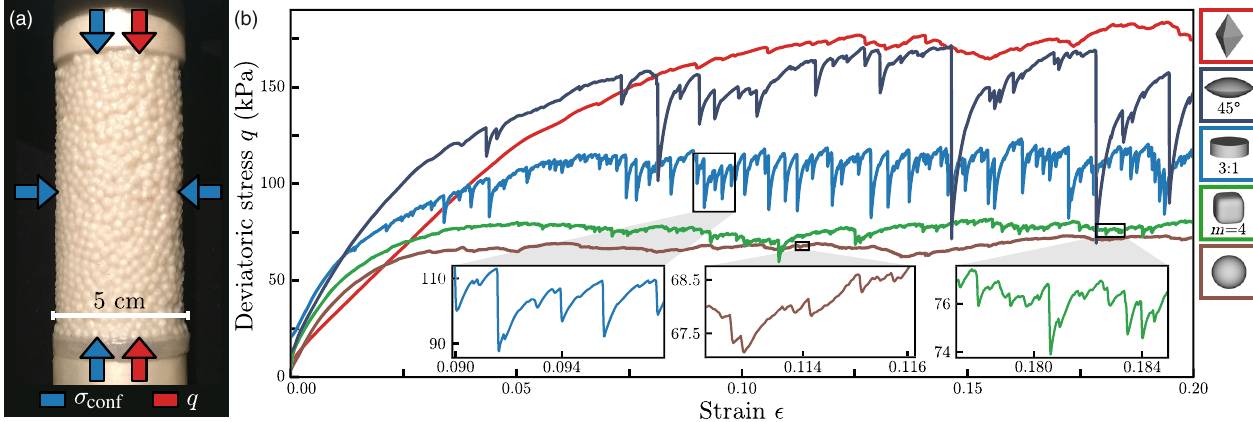
FIG. 1. Triaxial compression into the plastic regime. (a) A 10-cm-tall, 5-cm-diameter packing of icosahedra in a rubber membrane and ¼ 20 kPa before uniaxial stress q is applied. (b) Raw stress-strain data for a single run each for the five particle shapes evacuated to σ conf shown on the right (see Table I for shape definitions). All data in this paper are from the range ϵ ¼ ½ 0 . 1 ; 0 . 2 (cid:3) . Insets: Magnified portions of the compression data for (left to right) the 3:1 disk, sphere, and m ¼ 4 supercube particles show the same sudden stress drops, though at different stress